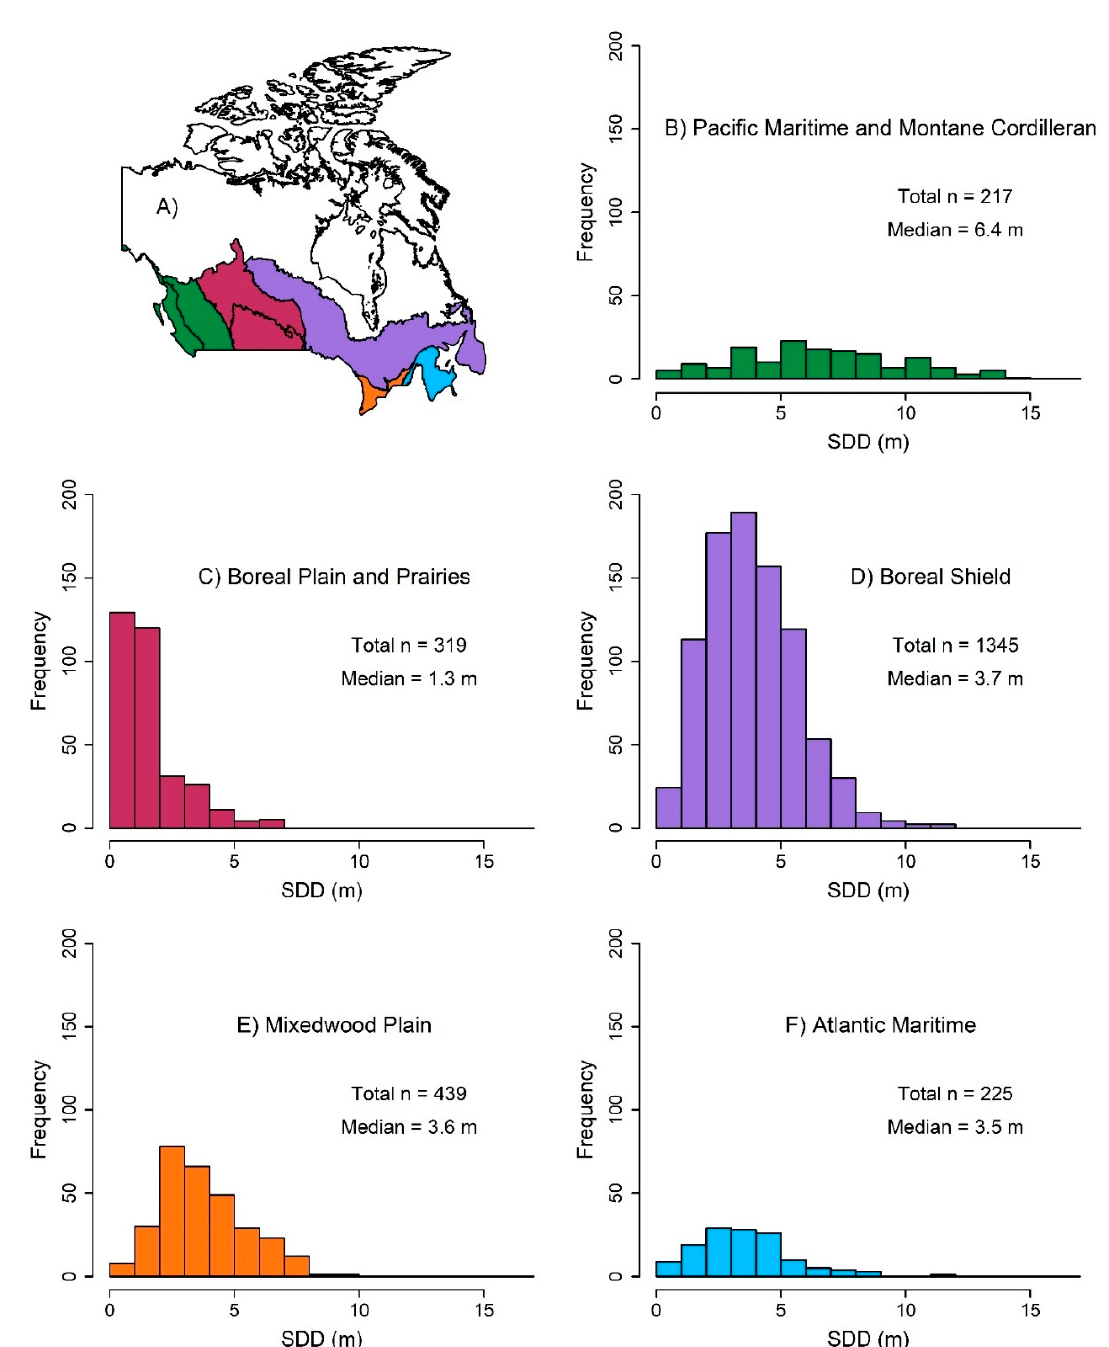
Figure 1. Histograms showing the frequency of unique sampling points per SDD (m). ( A ) shows the color coded ecozone map corresponding to each of the following graphs. ( B – F ) show histograms for each of the ecozones assessed in this study.